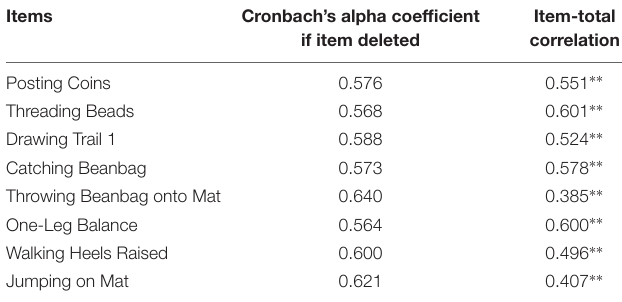
TABLE 2 | Internal consistency of test